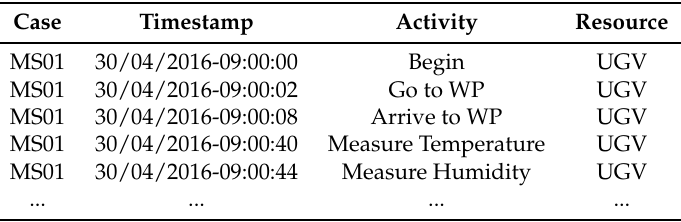
Table 4. A fragment of the event log of a